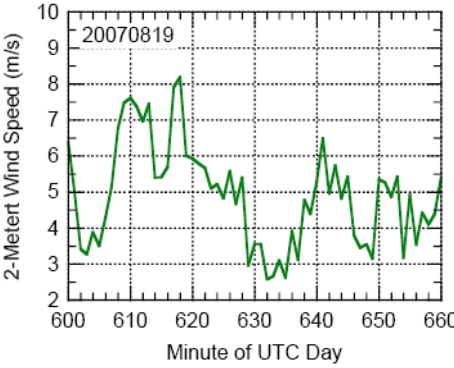
Fig. 8 Same as Fig. 6 but for second 60-minute period. Fig. 8. Same as Fig. 6 but for second 60-min period.